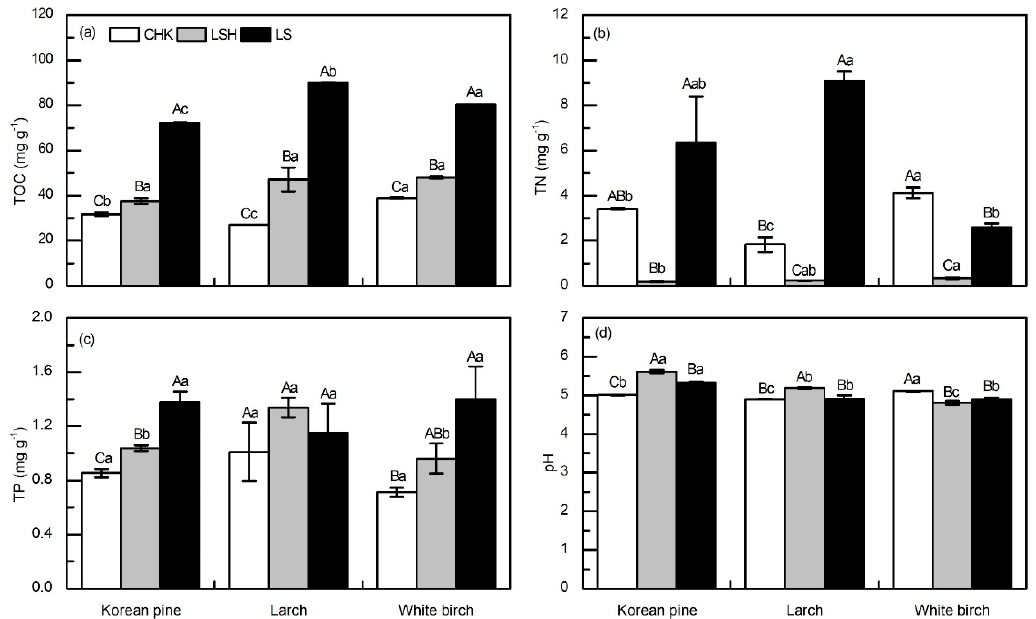
Figure 3. Soil chemical traits of Korean pine, larch, and white birch plantations at three sites in Northeast China. ( a ) total organic carbon (TOC), ( b ) total nitrogen (TN), ( c ) total phosphorus (TP), and ( d ) pH. Vertical bars are means ± SE, with a sample size of n = 6. Different capital letters indicate significant differences ( p < 0.05) within a site. Different lowercase letters indicate significant differences ( p < 0.05) within a species.